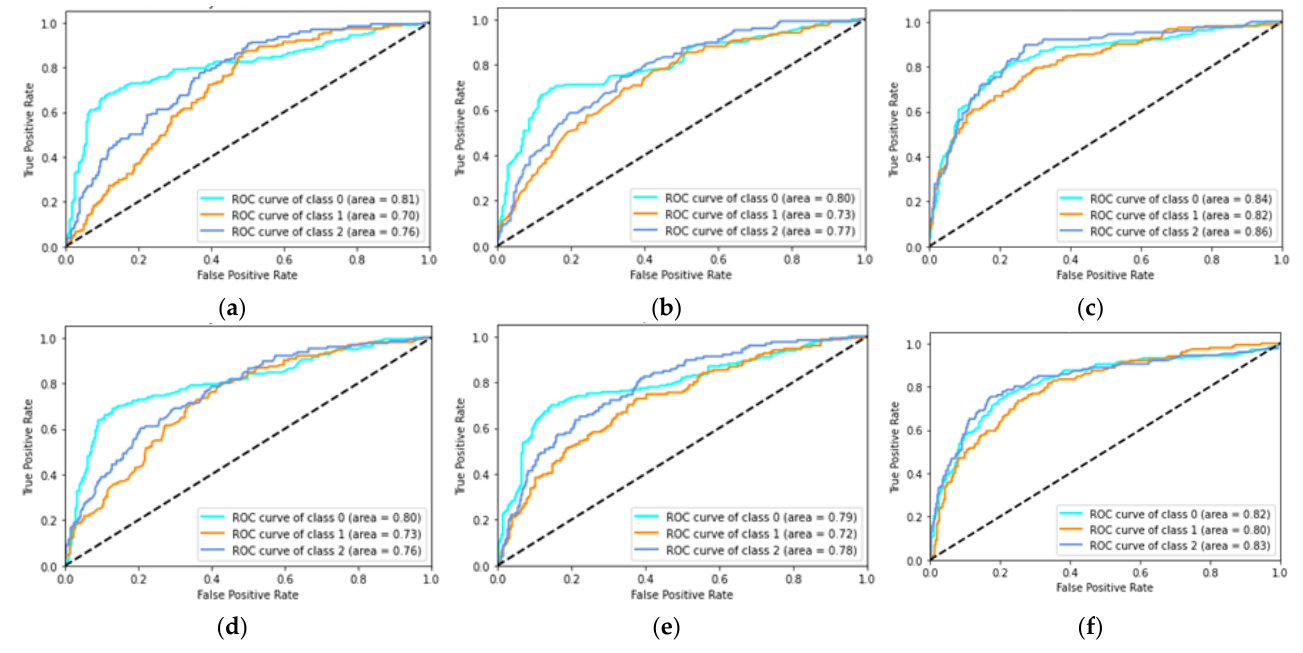
Figure 4. RFC classification of Healthy, COPD, and Pneumonia one-vs-rest ROC curves for each SVD element and real and imaginary components of the signals: ( a ) ROC curves of real components of SVD U element; ( b ) ROC curves of real component of SVD V T element; ( c ) ROC curves of real component of SVD S element; ( d ) ROC curves of imaginary component of SVD U element; ( e ) ROC curves of imaginary component of SVD V T element; ( f ) ROC curves of imaginary component of SVD S element.